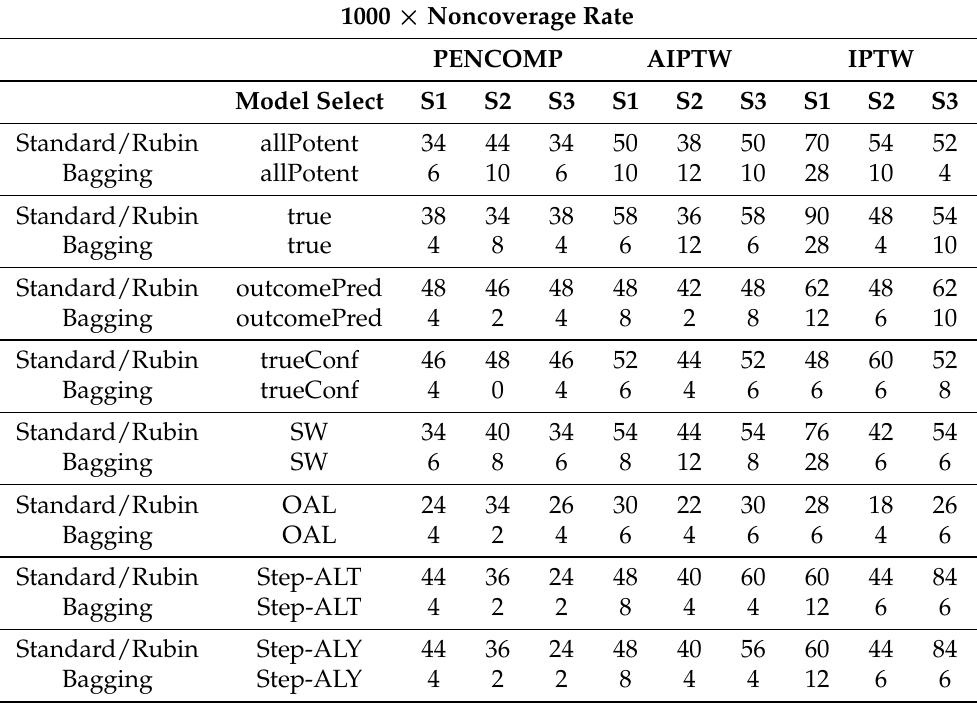
Table 4. 1000 × noncoverage rate (5%) with sample size of 1000. The nominal coverage is 95%.